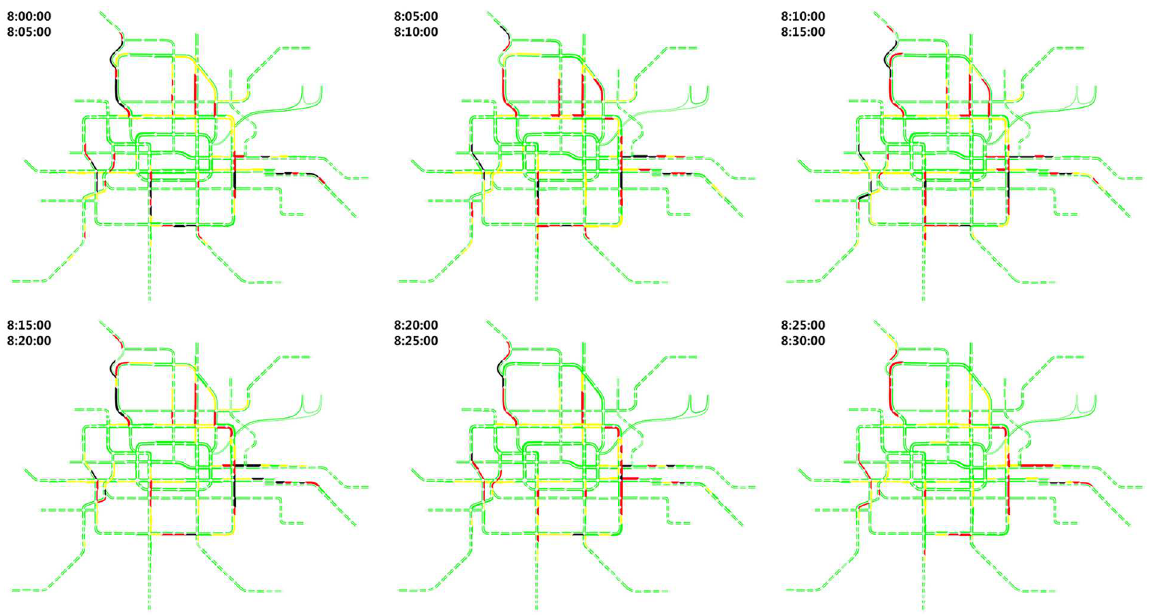
Fig 12. The passenger flow status at every5 minutes on the rail network from 8:00–8:30. We can simulate every moment of each passengerin our passengersimulator. In addition,once trains enter the segment, the passengers in the trains is countedby the segment, and the train’s capacityis also merged. If N stands for the total passengercount and Ca stands for the capacityof all the trains passingthrough the segment, the train load of the segment can be calculatedas N / Ca . We use four colors to displaythe train load of each segment: lime indicatesa load range from zero to 80%; yellow indicatesa load from 80% to 100%; red indicatesa load from 100% to 120%; and black indicatesthat the load is greater than 120%. doi:10.1371/journal.pone.0167126.g012 (2) Alternatives of origin stations . Figs 18 and 19 show in detail the top stations that pas-